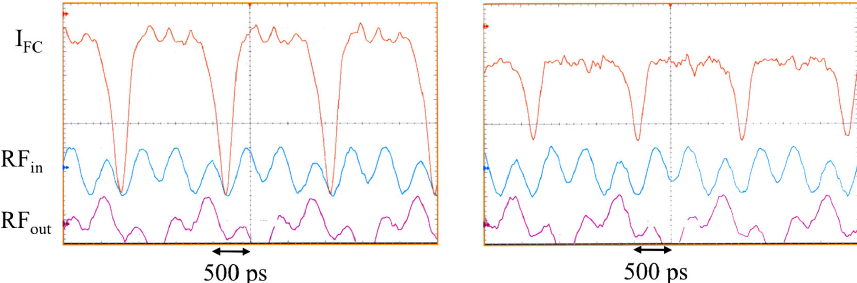
FIG. 7. Faraday cup data for combined first and third harmonic modulation of the electron gun and higher negative grid bias for ¼ (cid:2) 36 kV , (cid:1) 200 W at 714 MHz and (cid:1) 450 W at 2142 MHz. The left traces correspond to V V cathode ¼ (cid:2) 125 V . correspond to V grid